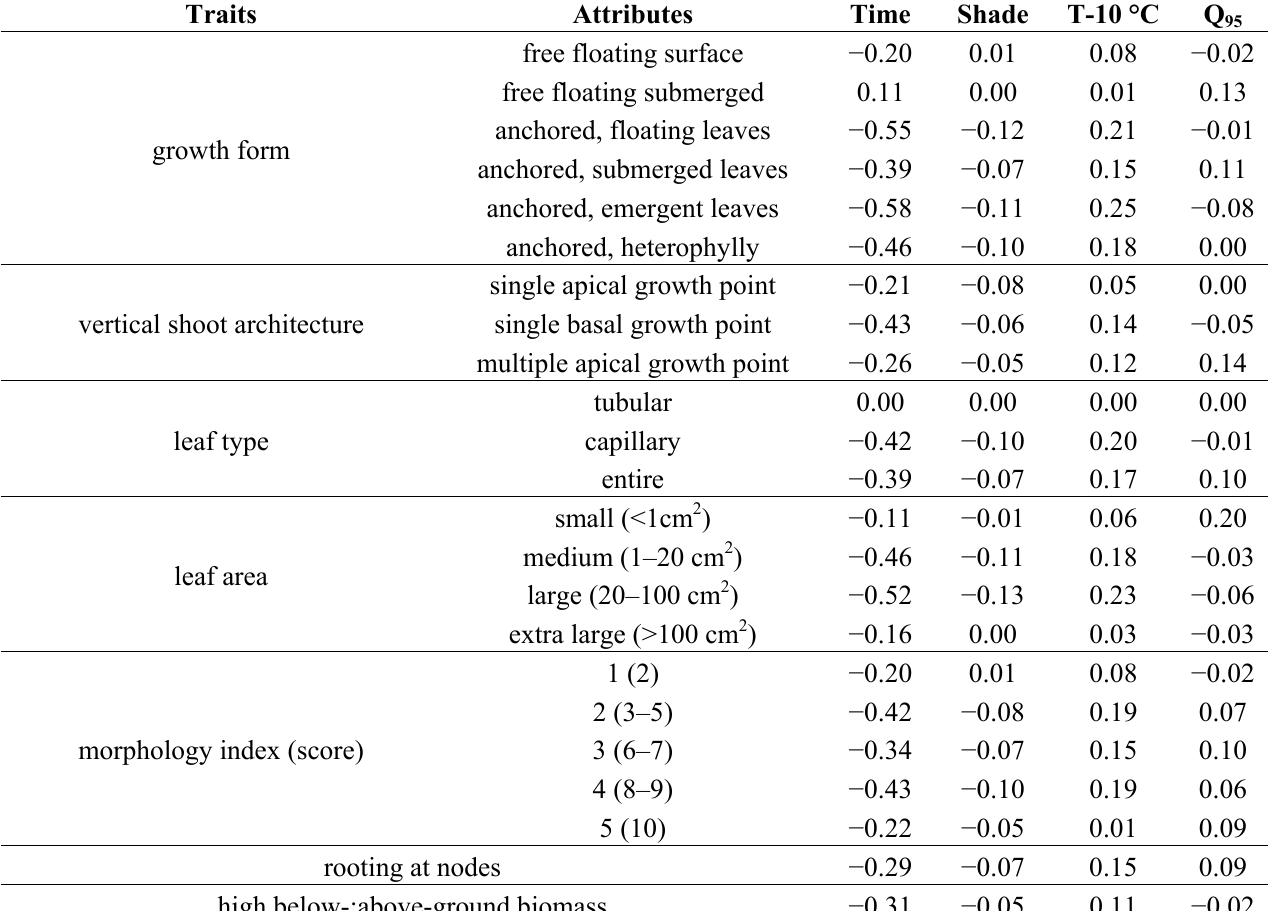
Table 2. Species attribute response (correlation coefficient) to time and exogenous factors.